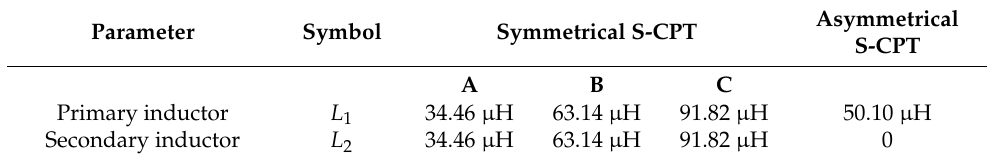
Table 2. Analysis results on the S-CPT